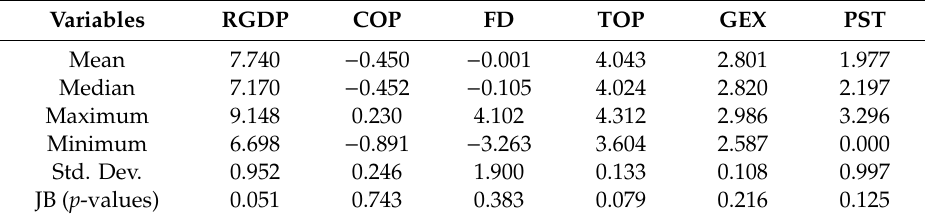
Table 3. Summary of